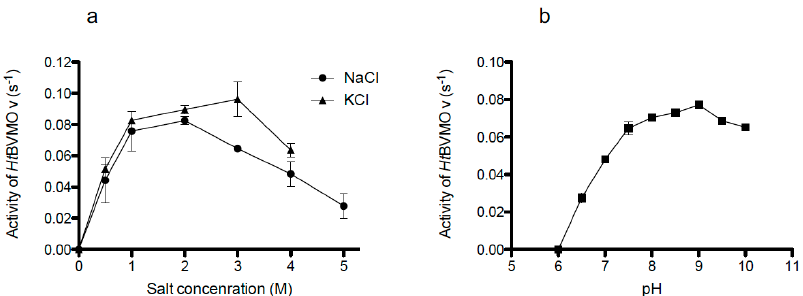
Figure 4. E ff ect of salt concentration and pH on the activity of Ht BVMO. ( a ) Activity at constant pH (50 mM TRIS-HCl pH 8.0) and varying NaCl or KCl concentrations. ( b ) Activity at a constant salt concentration (2.0 M NaCl) and varying pH (TRIS–MES and acetate bu ff er). Values are means ± SD (n =